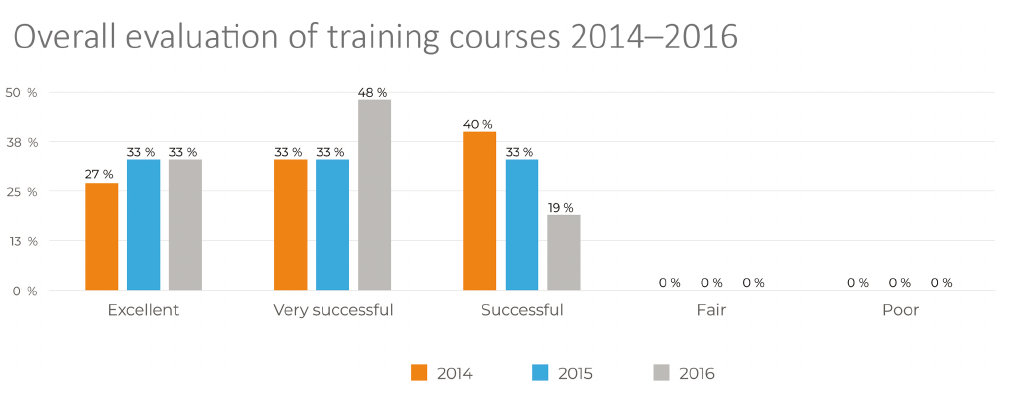
Figure 1. Overall evaluation of training courses